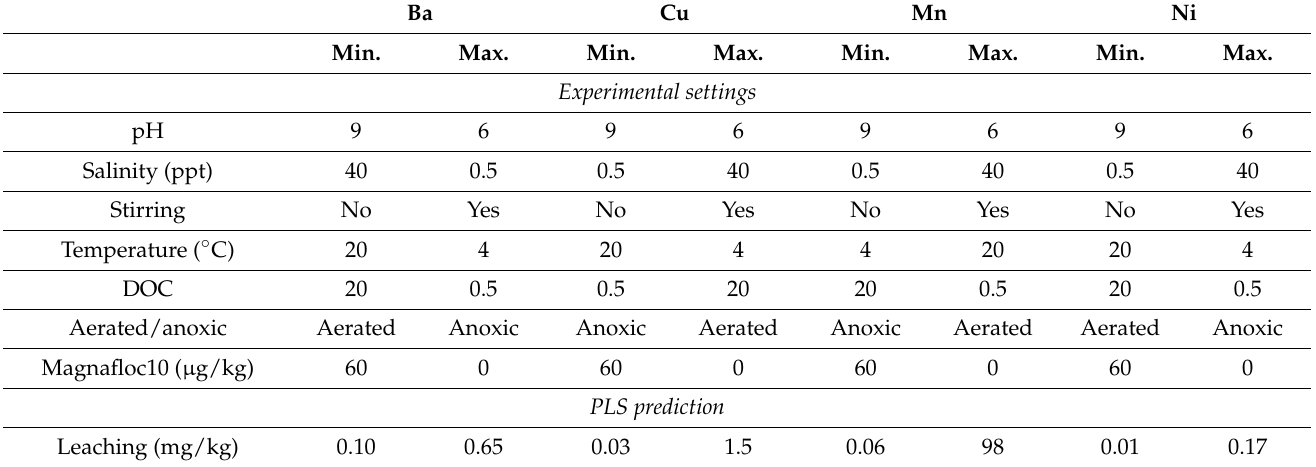
Table 5. Predicted leaching of metals in the experimental domain of the leaching experiments. Minimum leaching was predicted in the PLS models by using the experimental settings of each variable that gave the lowest leaching for each metal. Maximum leaching was predicted in the PLS models by using experimental settings of each variable that gave the highest leaching for each metal. Ba Cu Mn Ni Min. Max. Min. Max. Max. Experimental settings